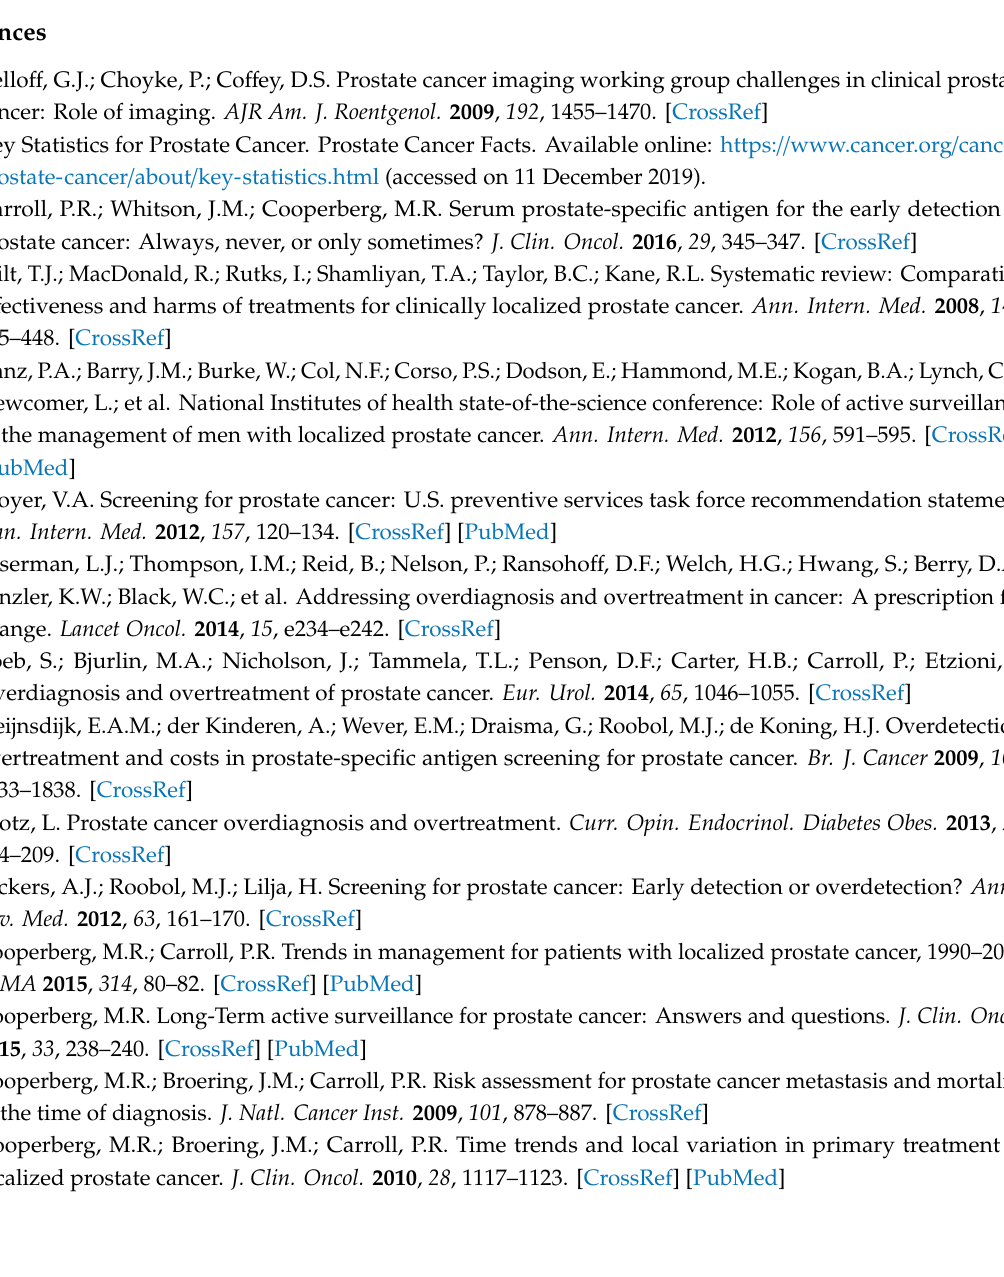
Figure S1: Live / Dead assay for measuring tissue